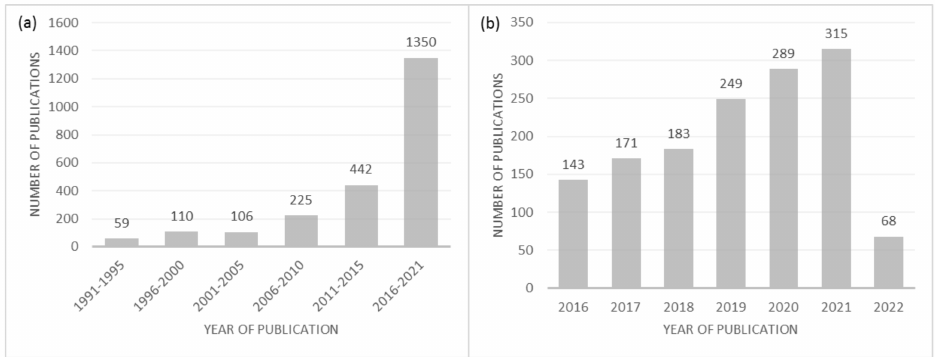
Figure 1. Number of publications on the subject—selected from Web of Science, with the keywords: “pyrolysis” and “end-of-life tires”, “waste tires”, or “used tires”. ( a ) Number of publications between 1991 and 2021; ( b ) Number of publications per year between 2016 and 2022